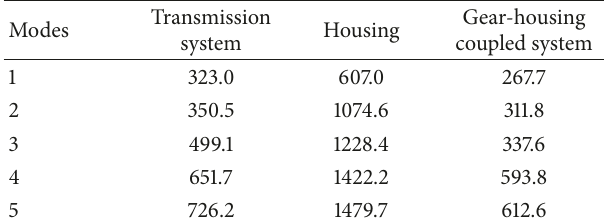
Table 4: System natural frequency